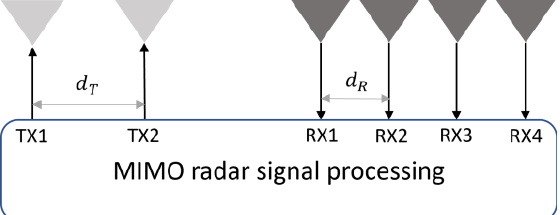
Fig. 1. Automotive radar(vehicle ego) and two target vehicles [29]